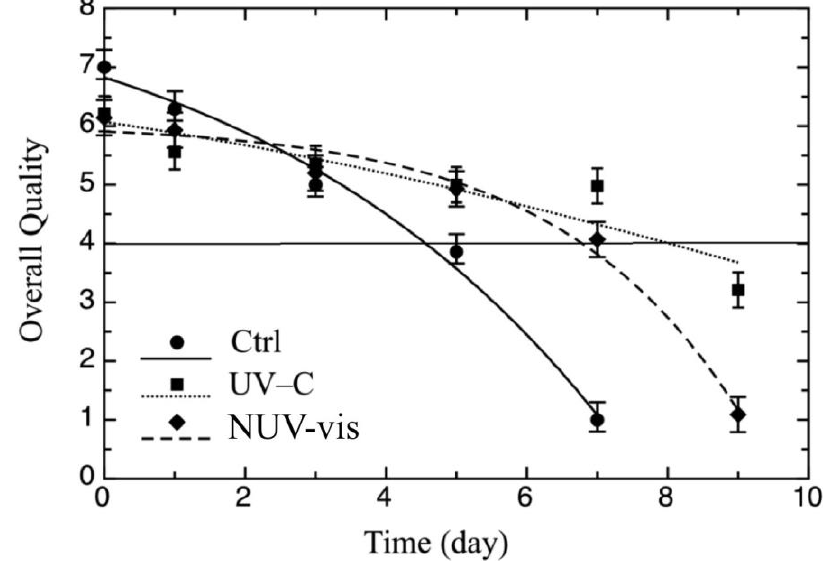
Figure 4. Evolution of sensory quality during the shelf life test of ricotta cheese inoculated with P. fluorescens (DSM 50090) (10 3 CFU / mL), treated with UV-C and NUV–vis light, at one light dose per technology, with respective control samples (Ctrl). A total of 36 samples were treated once, on the same day, which corresponded to time zero of the storage period, and then analyzed for 9 days. The continuous line represents the best fitting of Equation (2) to the experimental data of sensory quality. The horizontal line represents the threshold for overall quality acceptability set to 4.